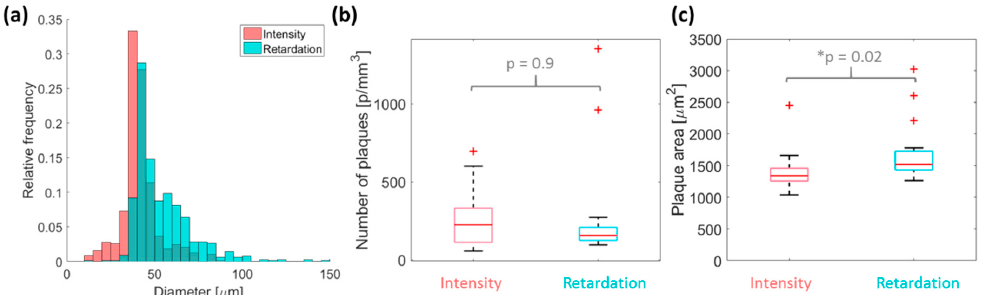
Figure 5. Statistical evaluation of segmented data sets. ( a ) Histogram of plaque diameters measured for intensity and retardation data sets. ( b ) Absolute numbers of plaques per mm 3 in intensity and retardation images. The amount of plaques visualized in intensity data (median of 224 [Q1–Q3: 112–332 p / mm 3 ]), as compared to retardation data (median of 156 [Q1–Q3: 124–208 p / mm 3 ]) was rather similar. ( c ) Mean plaquesizein µ m 2 calculatedforintensity(mean1394 ± 294 µ m 2 )andretardation(mean 1750 ± 608 µ m 2 ) data. For boxplots, mean values of each data set were